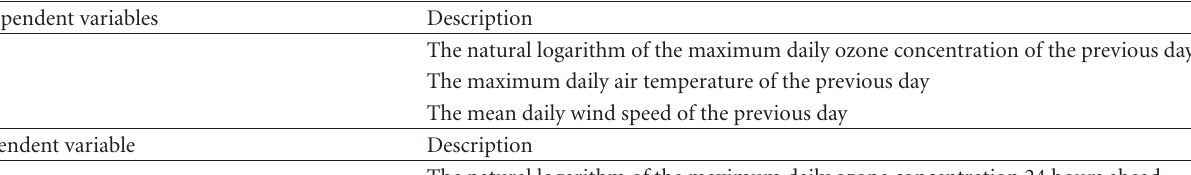
Table 1: Variables of the developed models.